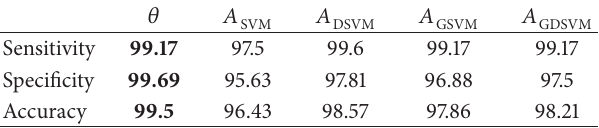
Table 3: Fall detecting results evaluated by combination of the simple threshold method with double parameters and